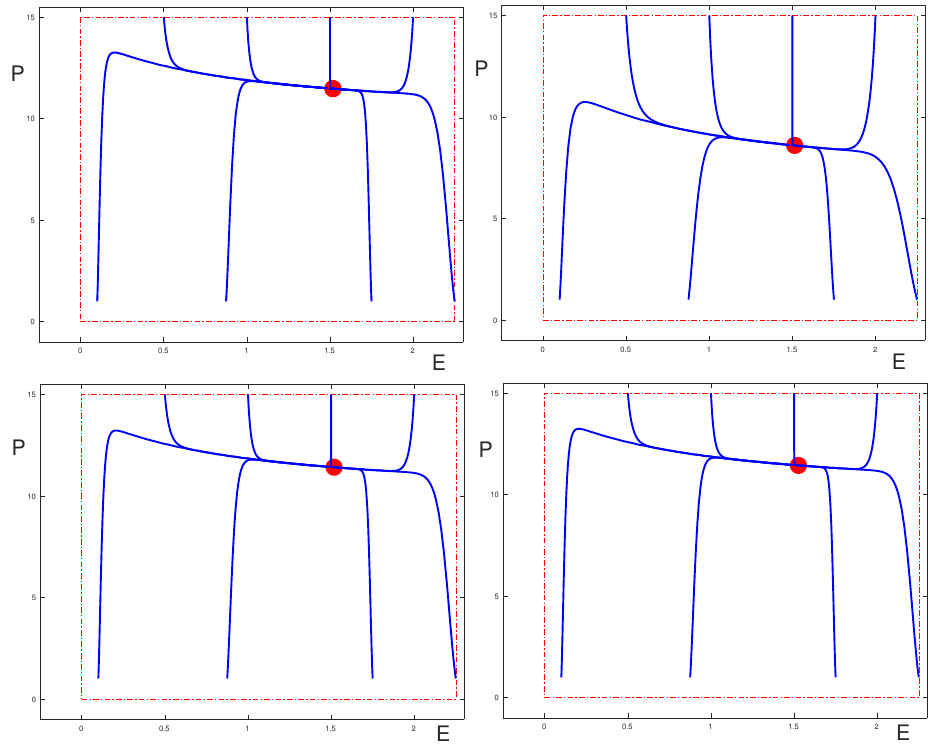
Figure 3. Phase portraits of the reduced dynamics for Q = 0 and P max,1 > P max,2 for the uncontrolled system ( top , left ) and for constant controls u 1 ≡ 1 ( top , right ), u 2 ≡ 1 ( bottom , left ) and u 3 ≡ 1 ( bottom , right ). The numerical values for these phase portraits are given in Tables 1 and